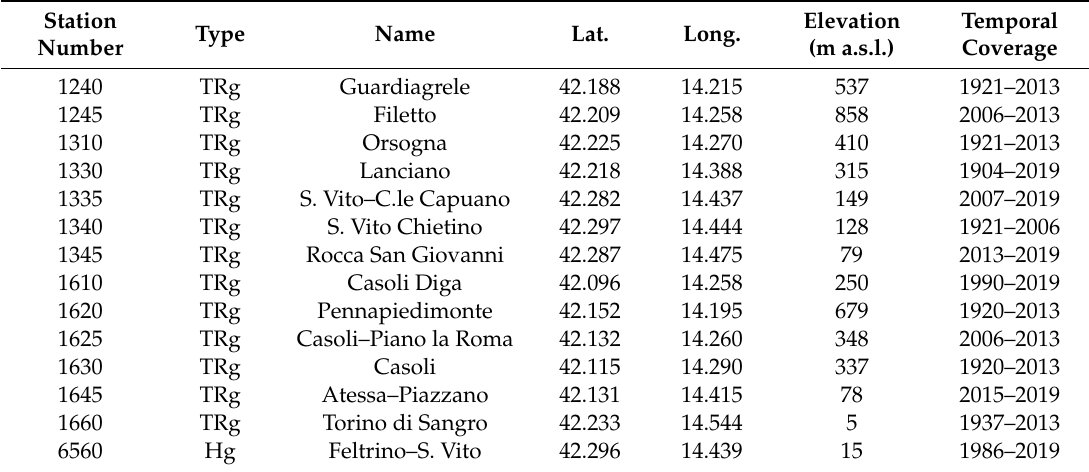
Table 2. Analyzed temperature and rainfall (TRg) and hydrometric (Hg)